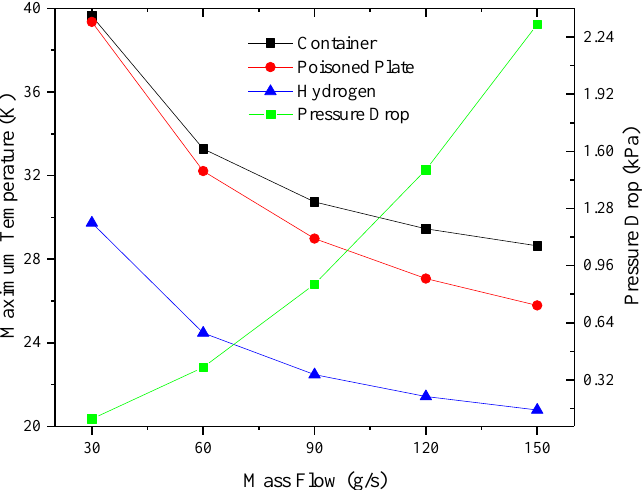
Figure 11. The variation of maximum temperature with different mass flow.